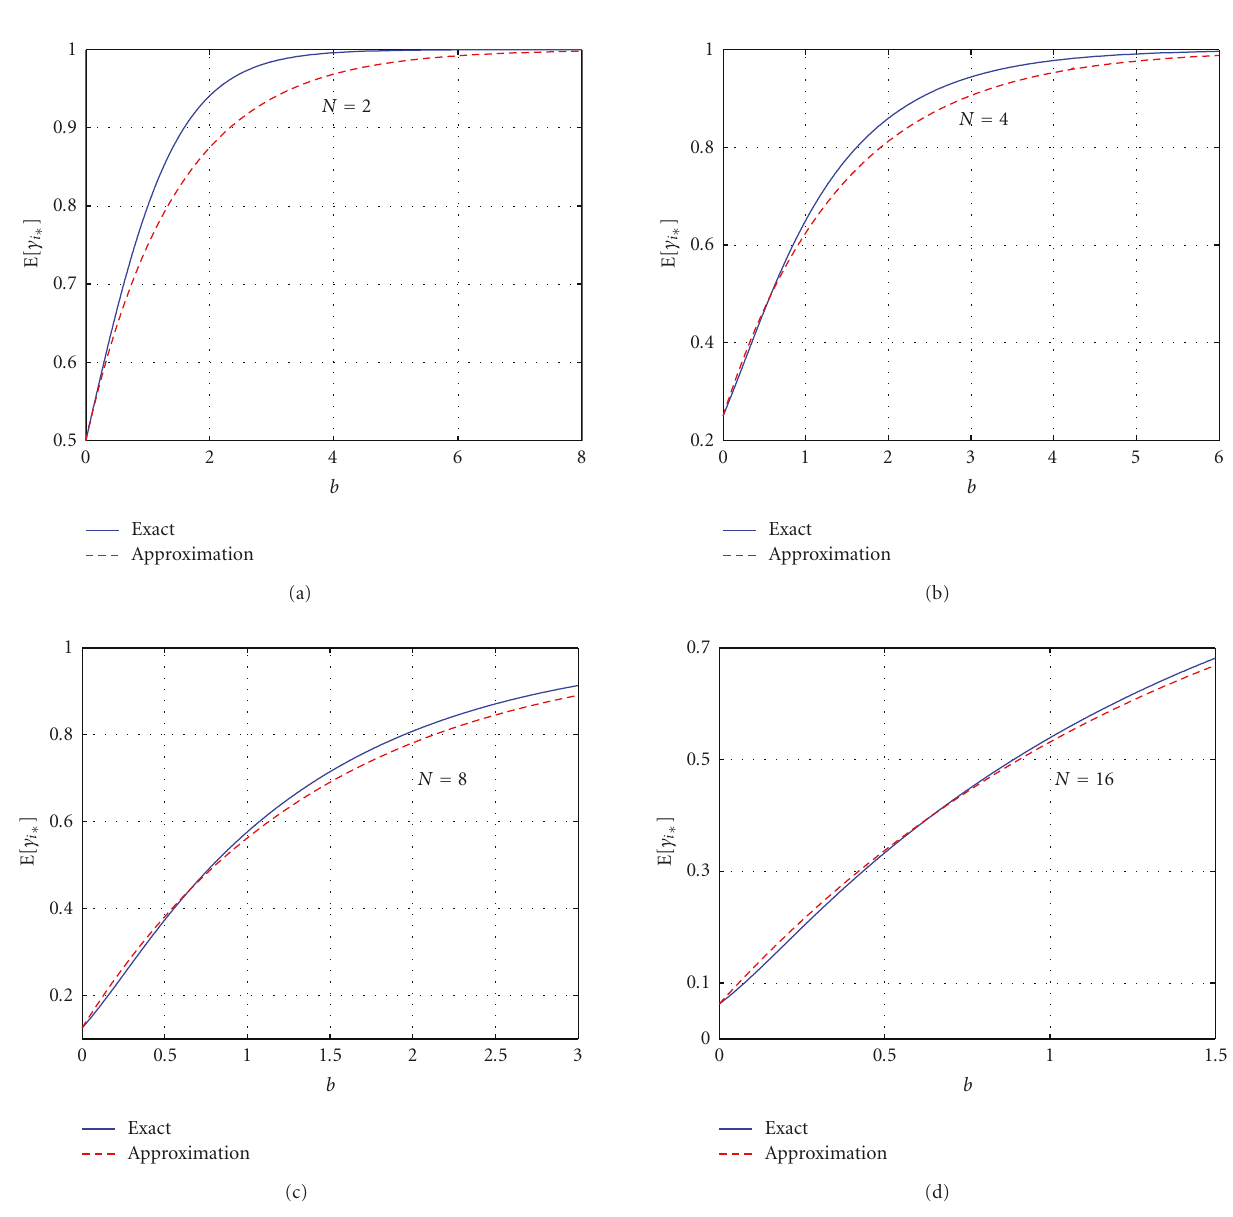
Figure 3: Comparison of the exact value of E[ γ i